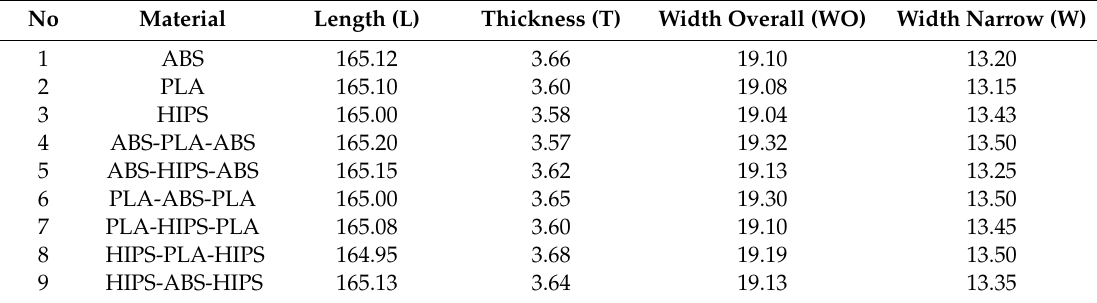
Table 3. Dimensions of the printed specimens.